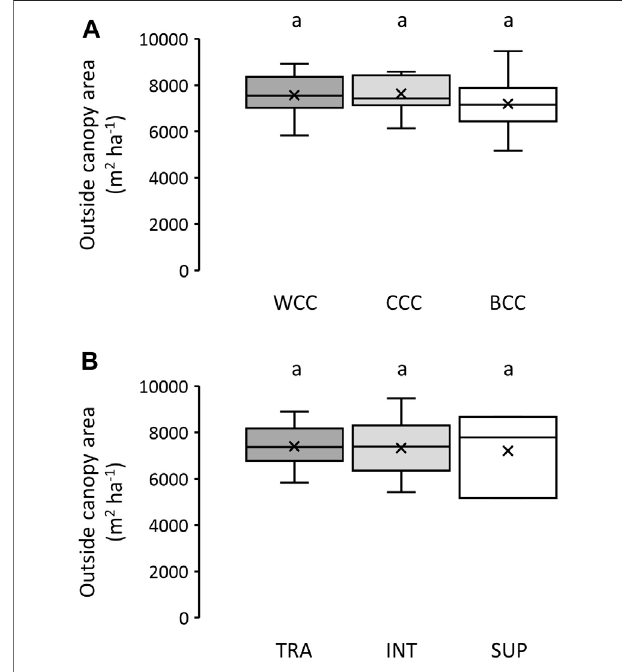
FIGURE 2 | Box and whiskers plot of the inter-row area of the olive groves for each of the cover crop layouts (A) and tree density categories (B) . Horizontal black line, x-shaped cross, box borders and whiskers stand for the median, the mean, quartiles and outliers. Different letters over the box- plot indicate signi fi cant differences ( p < 0.05). WCC, CCC and BCC stand for olives groves where TSCC occupied the whole area, was absent under tree canopy or only occupied a strip of the inter-row area, respectively. TRA, INT and SUP stand for olive grove with a traditional, intensive and superintensive tree